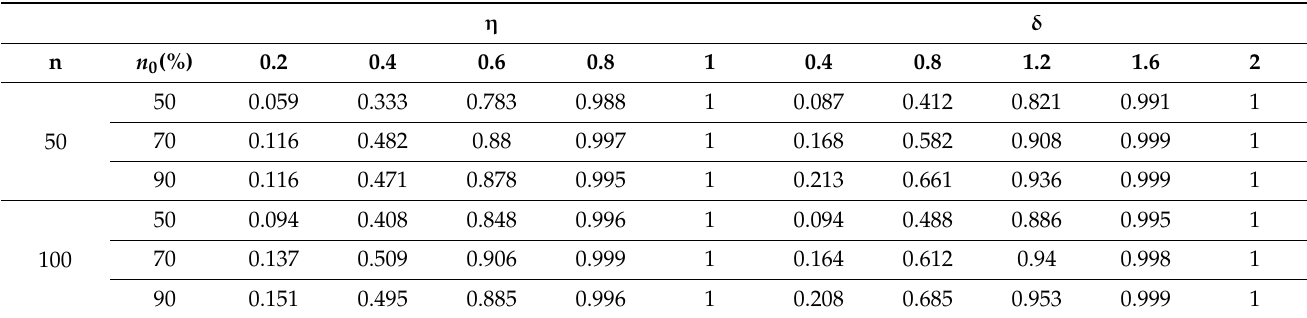
Table 6. Results of power estimates (1-Type II error) for variation in shape ( η ) and magnitude ( δ ) for the case of inter-curve dependence ( ρ 3 = 0.3), considering θ = 0.78.